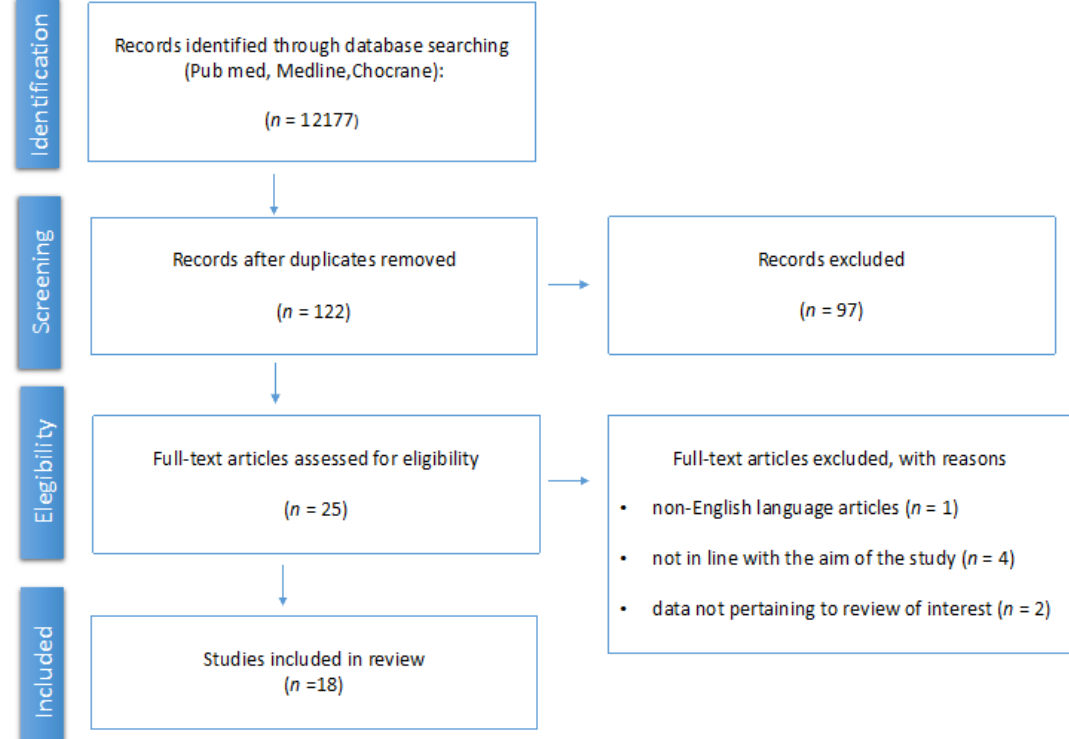
Figure 1. PRISMA flowchart for research strategy for the selected